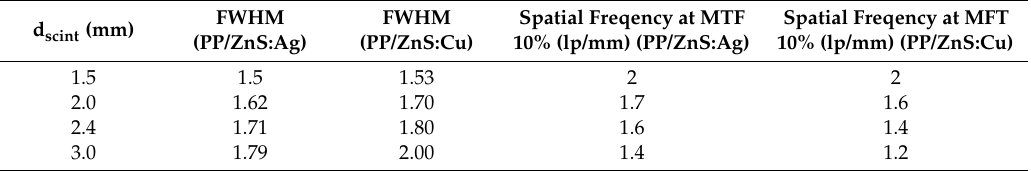
Figure 7. ( a , b ) Line spread functions obtained for the line profiles across the slit in the resolution mask; ( c , d ) modulation transfer functions corresponding to LSF curves in ( a , b ), respectively. Table 1. Calculated values of FWHM for the line spread functions presented in Figure 7a,b and spatial frequency values evaluated for MTF 10%.